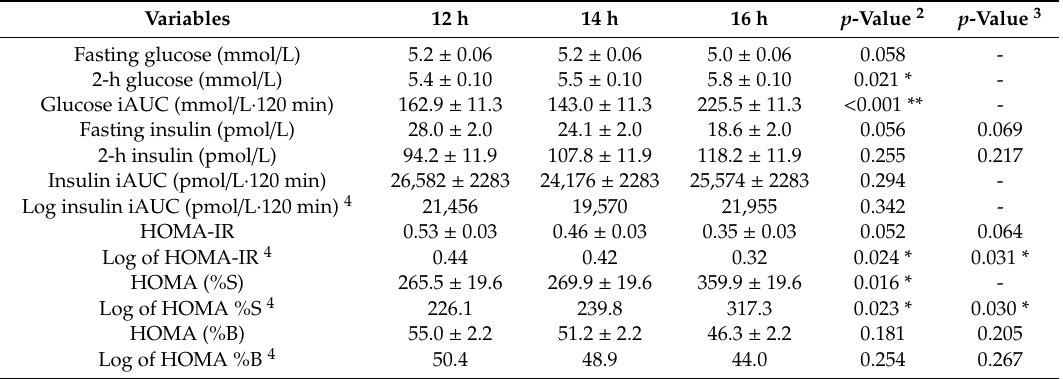
Figure 2. Incremental glucose response (iAUC) after 75 g carbohydrate standard breakfast at 12, 14, and 16 h fasting periods ( n = 24, p < 0.01, two-way ANOVA). There was also an overall significant difference in glucose iAUC between males and females over time ( p < 0.01, two-way ANOVA).